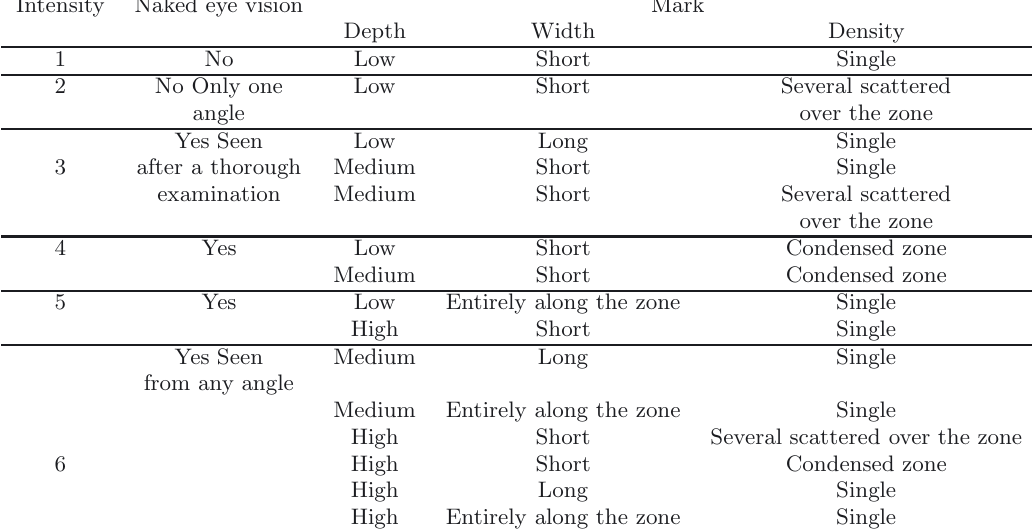
Table 2. An example of a table using a tree-like